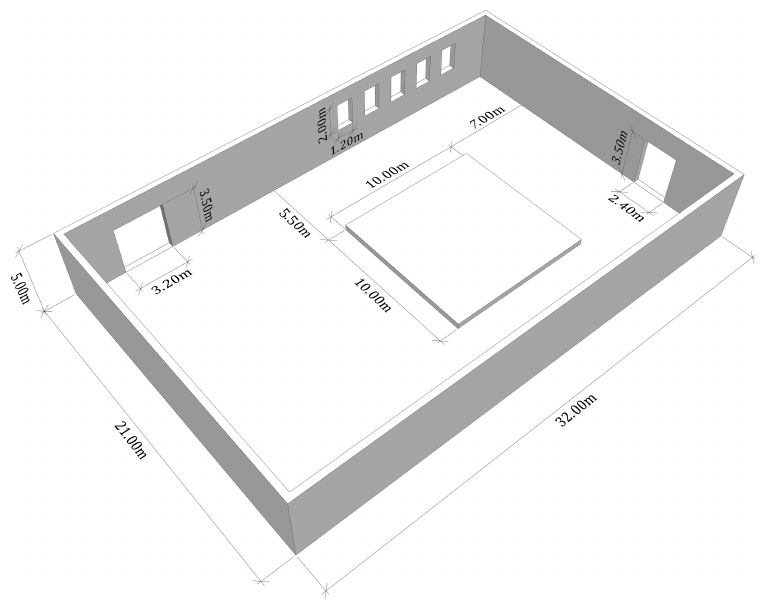
Figure 1. 3D map of the case